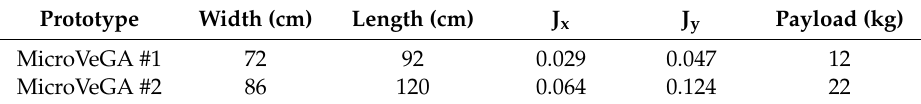
Figure 15. ( a ) MicroVeGA drone prototype #2 used during the survey; ( b ) navigation lines of bathymetric survey in blue and submerged archaeological structures in red.